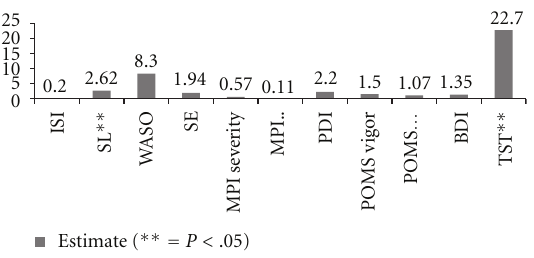
Figure 2: Change score end of treatment to six-month followup.